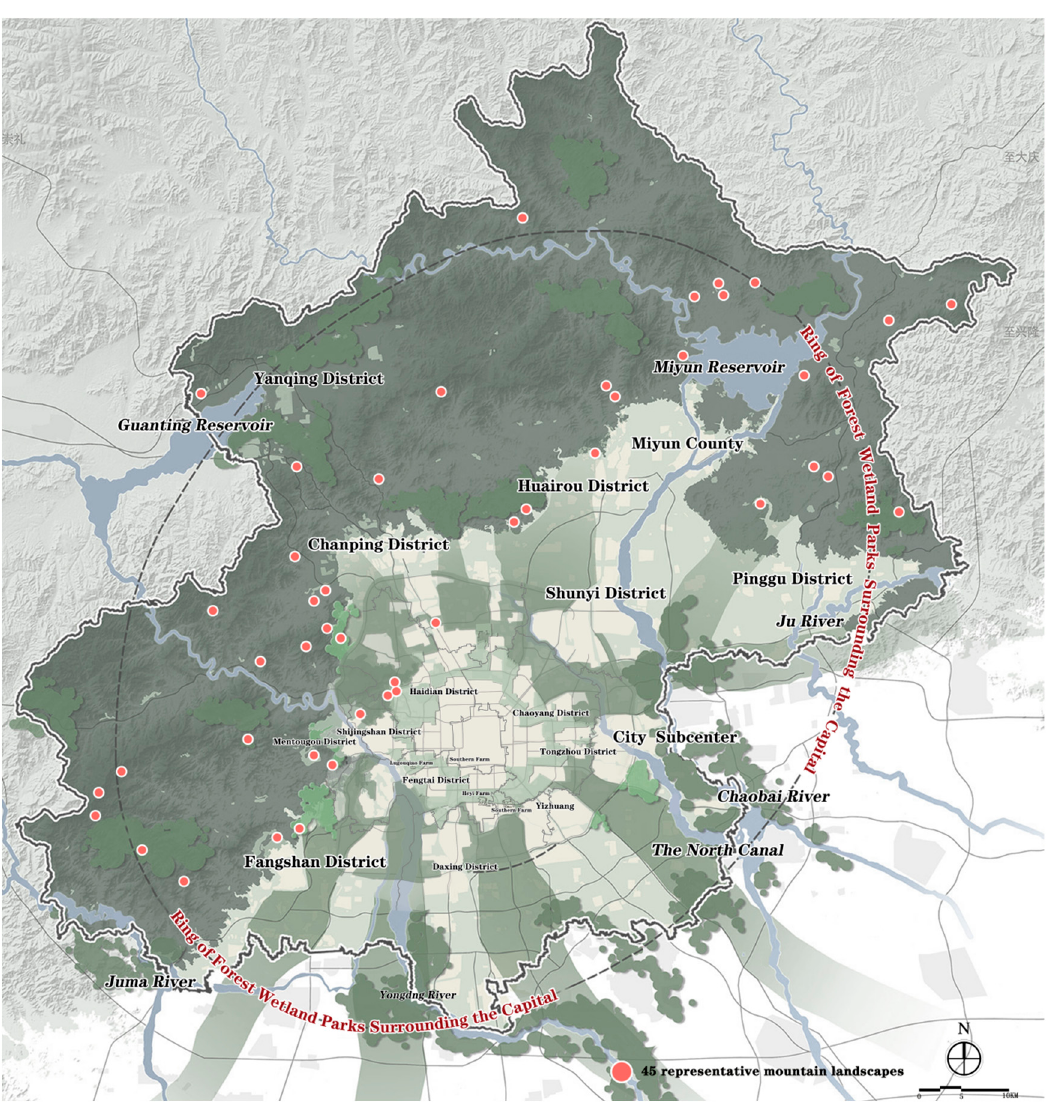
Figure 1. Distribution of the 45 representative mountain landscapes in Beijing.